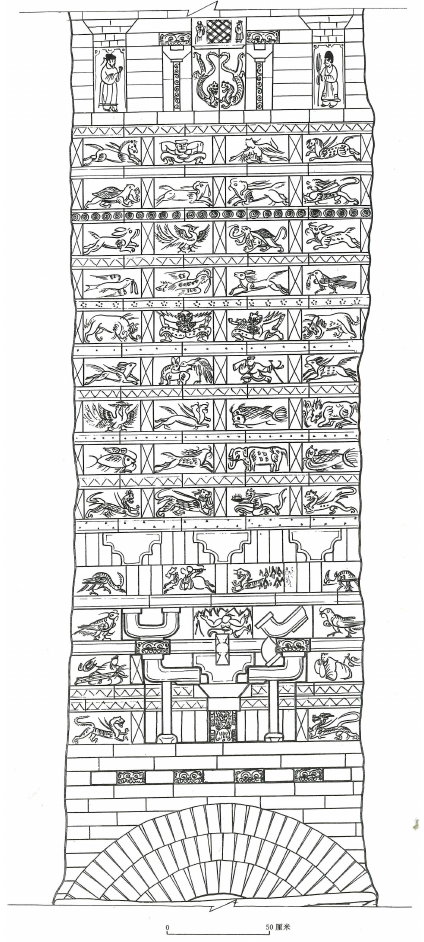
Figure 14. Screen wall, Foyemiaowan M133, carved and painted brick, Western Jin period (265–317). (Gansusheng Wenwu Kaogu Yanjiusuo 1998, Figure 23). ©Wenwu Press. This figure published with permission of Wenwu Press and cannot be used or copied without their permission.